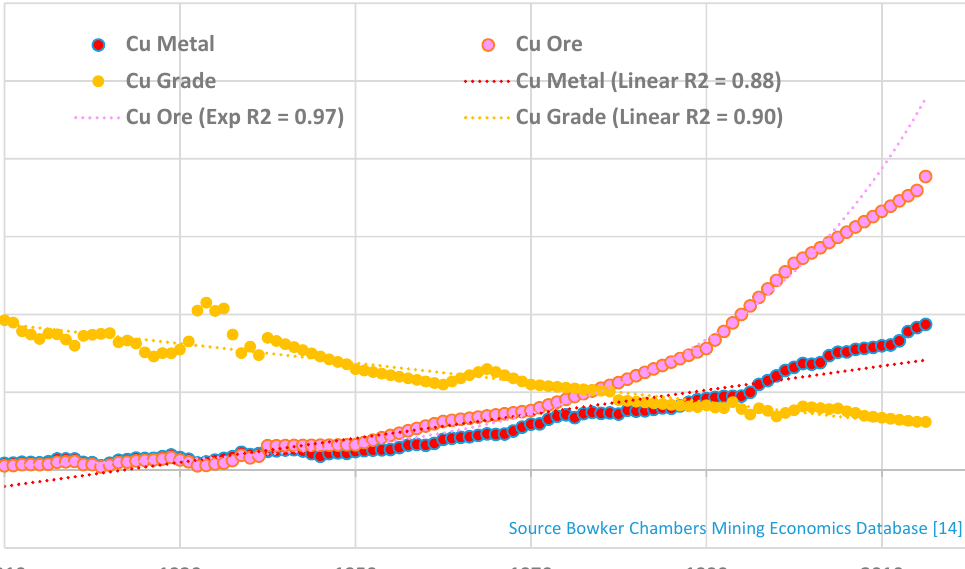
Figure 3. Failure trend increases despite lower costs & exponential price rises.